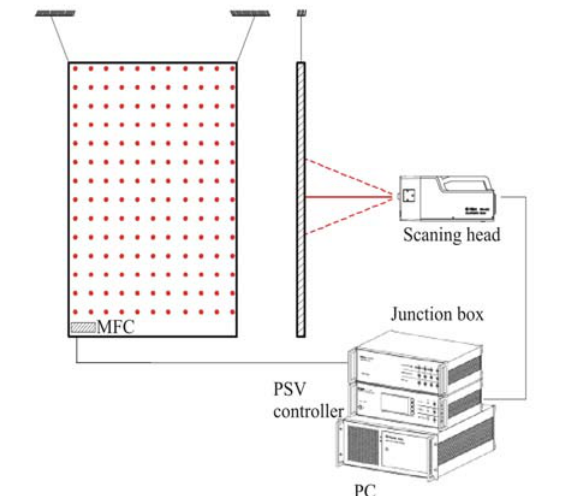
Fig 7. Experiment set-up with MFC